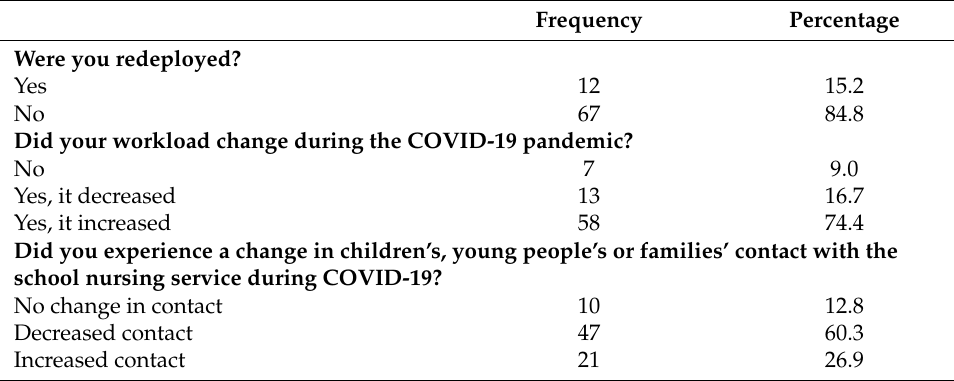
Table 2. Broad work profile change for school nurses as a result of the COVID-19